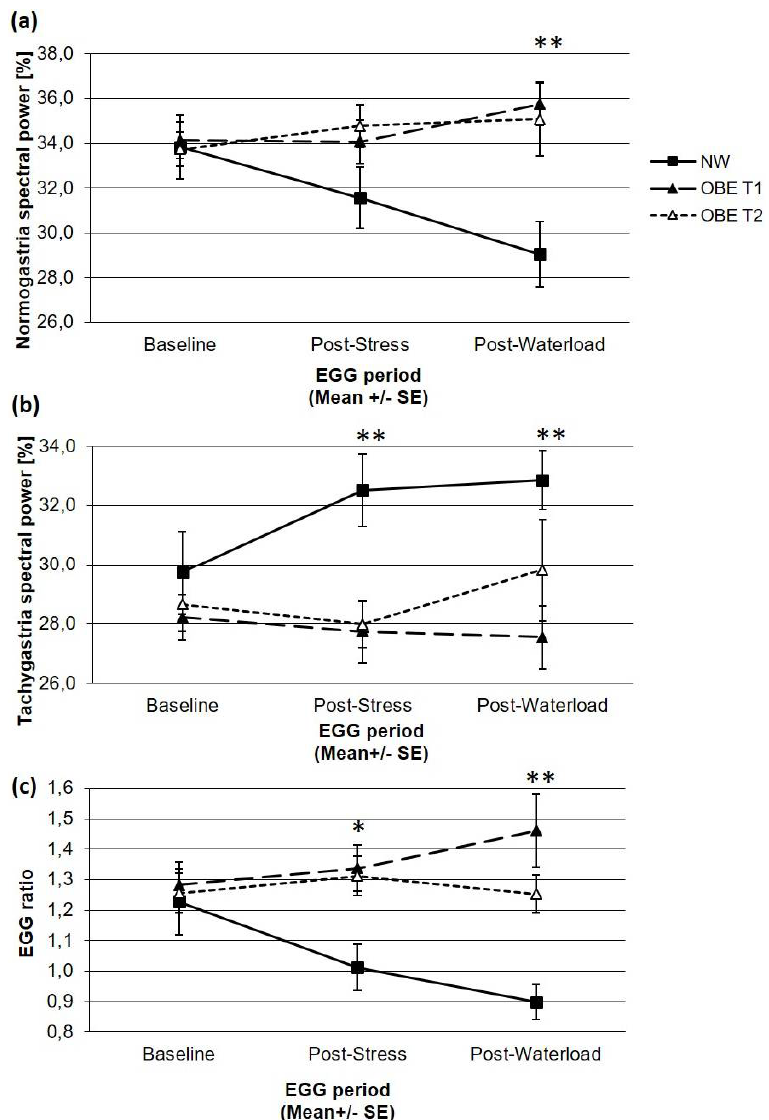
Figure 1. EGG parameters of gastric myoelectrical activity in children with obesity (OBE) before (T1) and after (T2) weight loss and normal-weight control children (NW), depicted as ( a ) normogastria spectral power (%), ( b ) tachygastria spectral power (%), and ( c ) the ratio between normogastria and tachygastria (comparisons between OBE T1 and NW: * FDR < 0.05, ** FDR < 0.01).